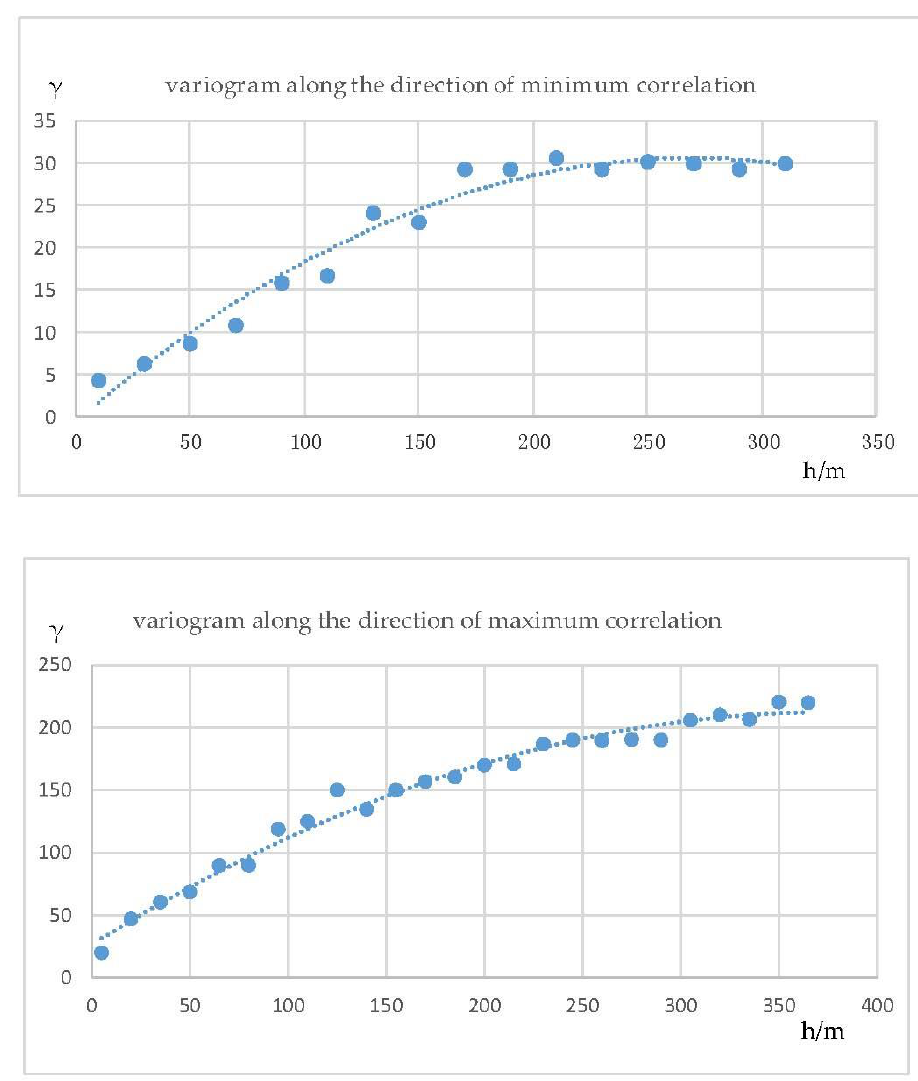
Figure 9. Variogram of different directions.